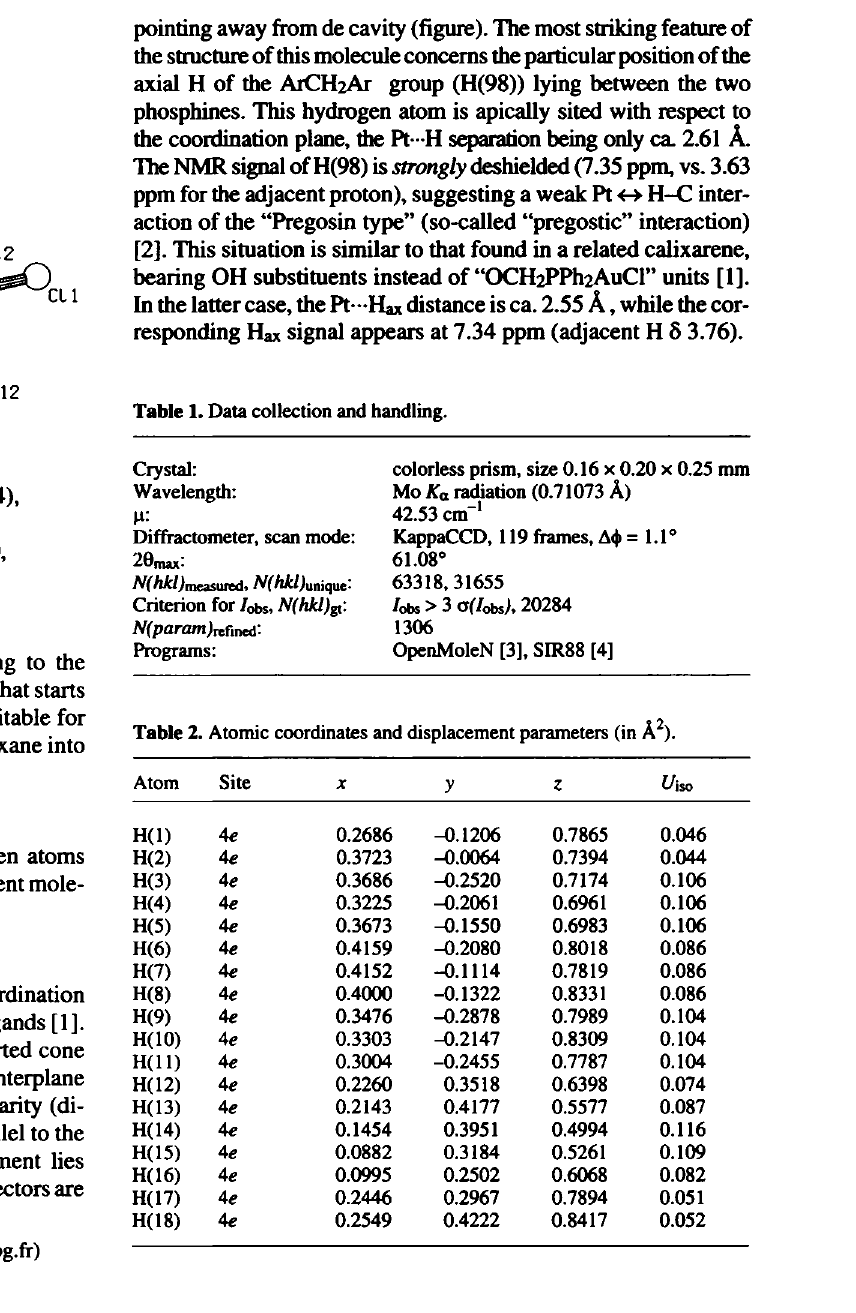
Table 2. Atomic coordinates and displacement parameters (in A 2